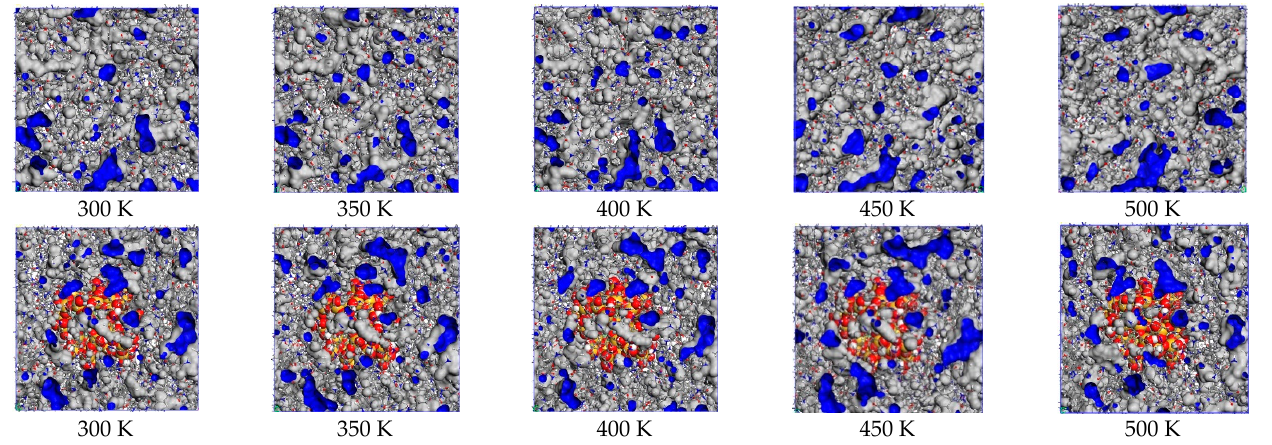
Table 2. Free volume ratio of the PMIA and SiO 2 /PMIA models at different temperatures.